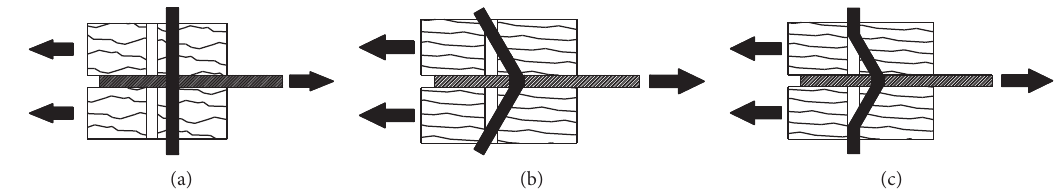
Figure 2: The yield modes of dowel-type fasteners in timber connections. (a) Mode I. (b) Mode II. (c) Mode